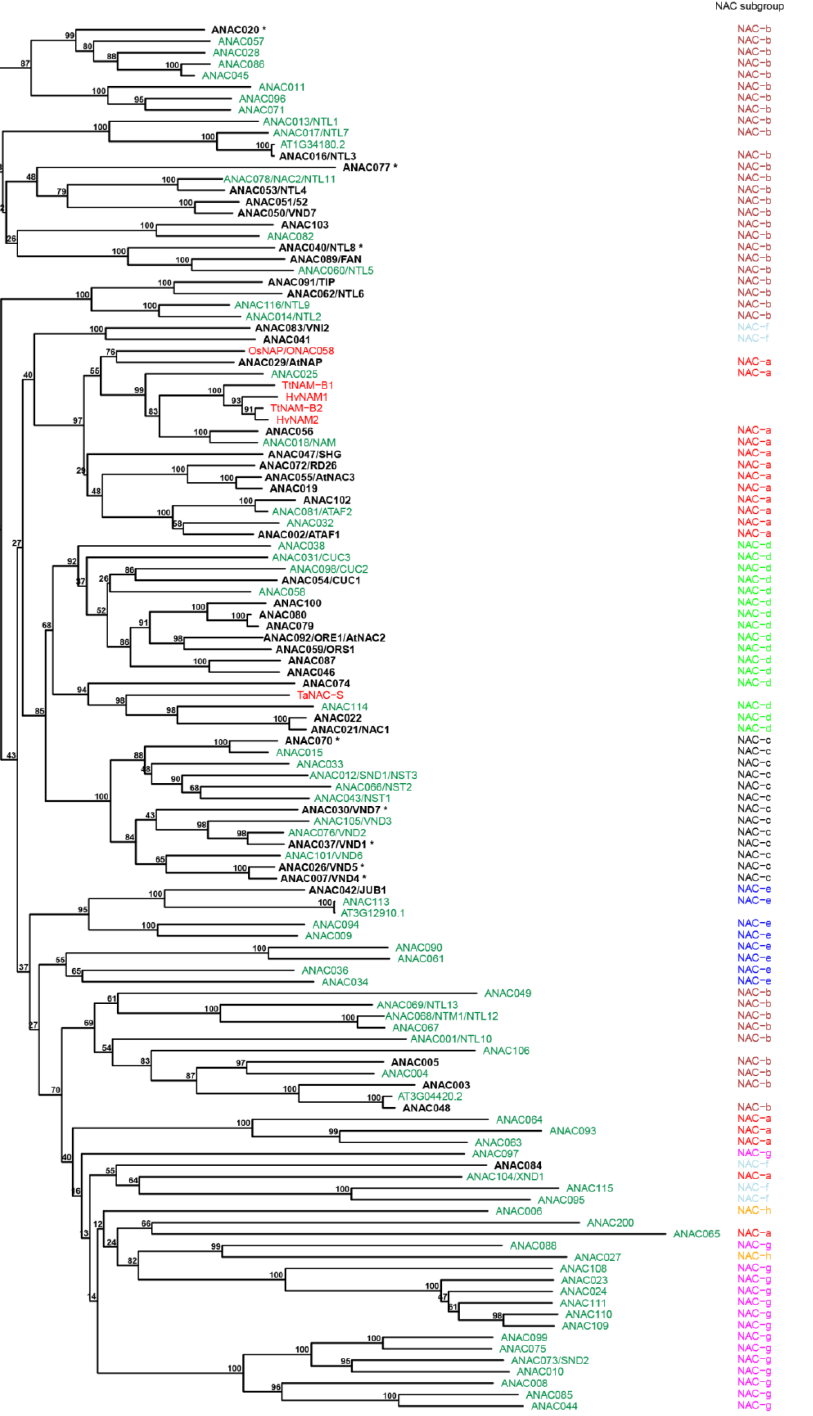
Figure 1. Phylogenetic presentation of NAC proteins. For Arabidopsis, the NAC proteins are shown in green with senescence-associated proteins highlighted in black and bold. Asterisks indicate down-regulation during senescence. For barley, wheat, and rice, only the senescence-associated proteins/genes discussed with respect to functional role in the text are shown in the tree. These proteins are shown in red. The tree was based on only the N-terminal NAC domain of the proteins and it was constructed using ClustalX [71] and the R add-on package ape [72]. The subfamily classification is based on the system proposed by Shen et al.